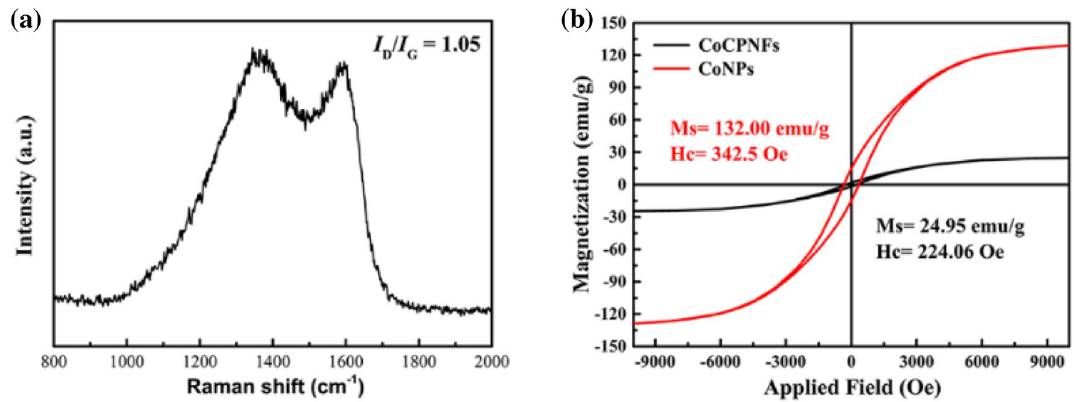
Figure 5. Raman spectrum ( a ) of Co/PCNF; hysteresis loop ( b ) of CoNPs and Co/PCNF at room